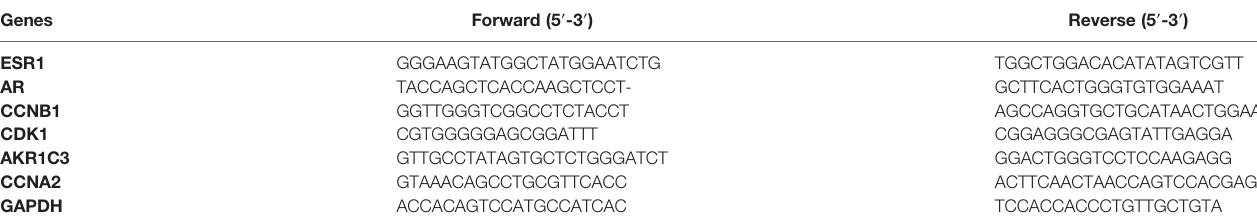
TABLE 1 | Primers for